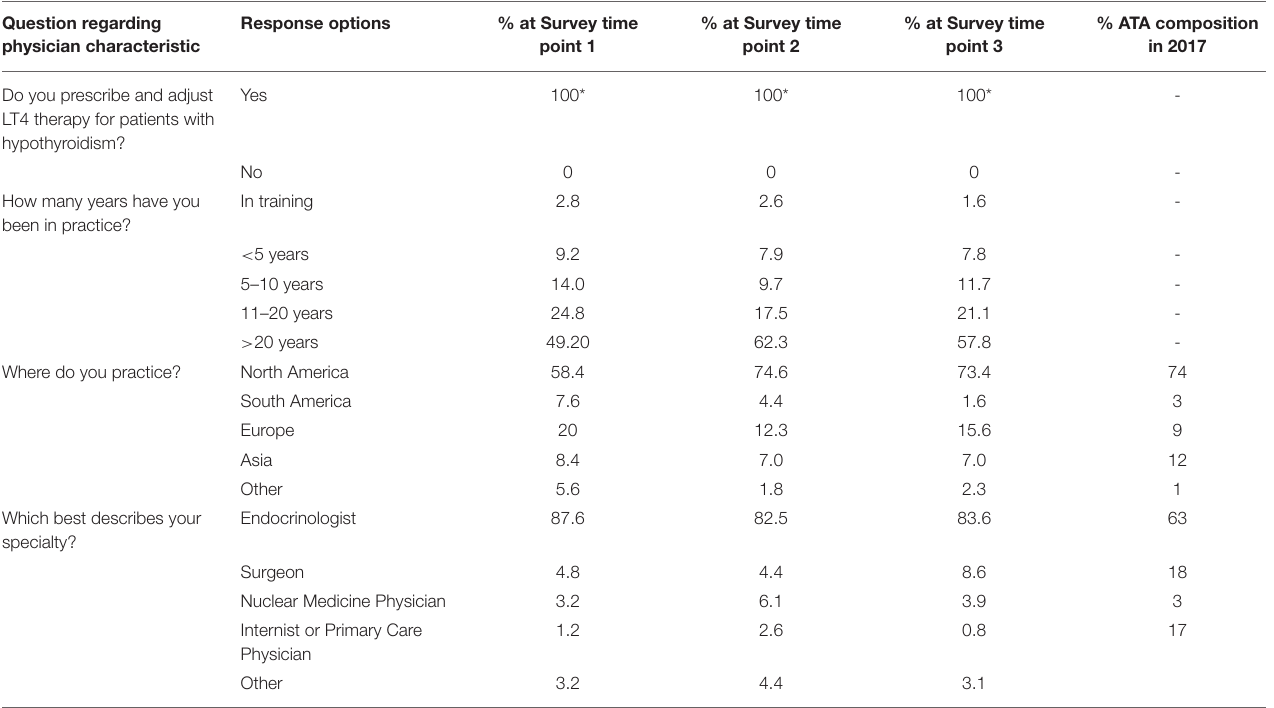
TABLE 3 | Characteristics of physicians responding to